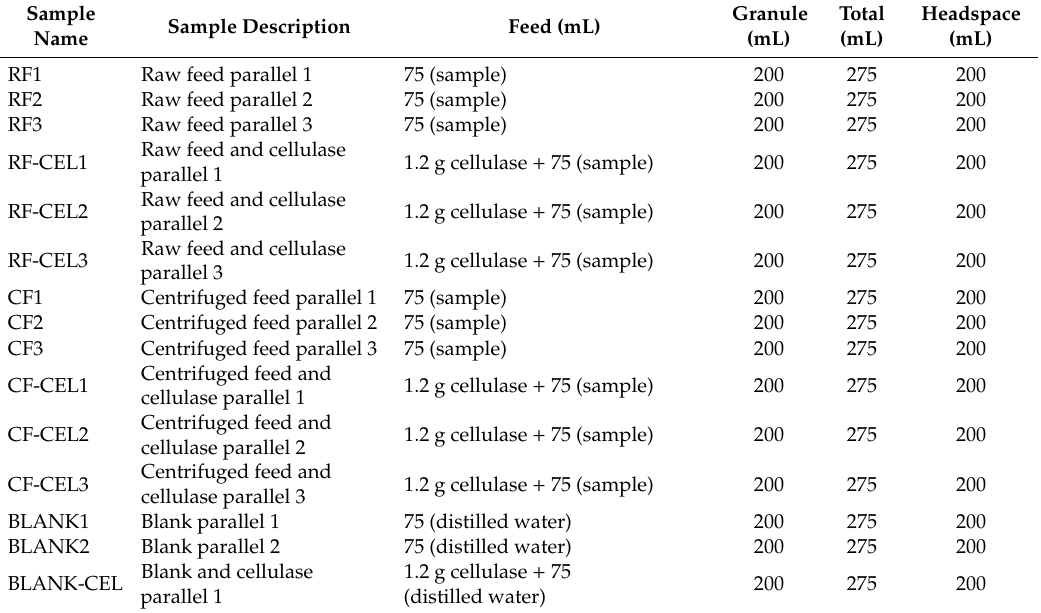
Table 2. Sample preparation for batch test initial